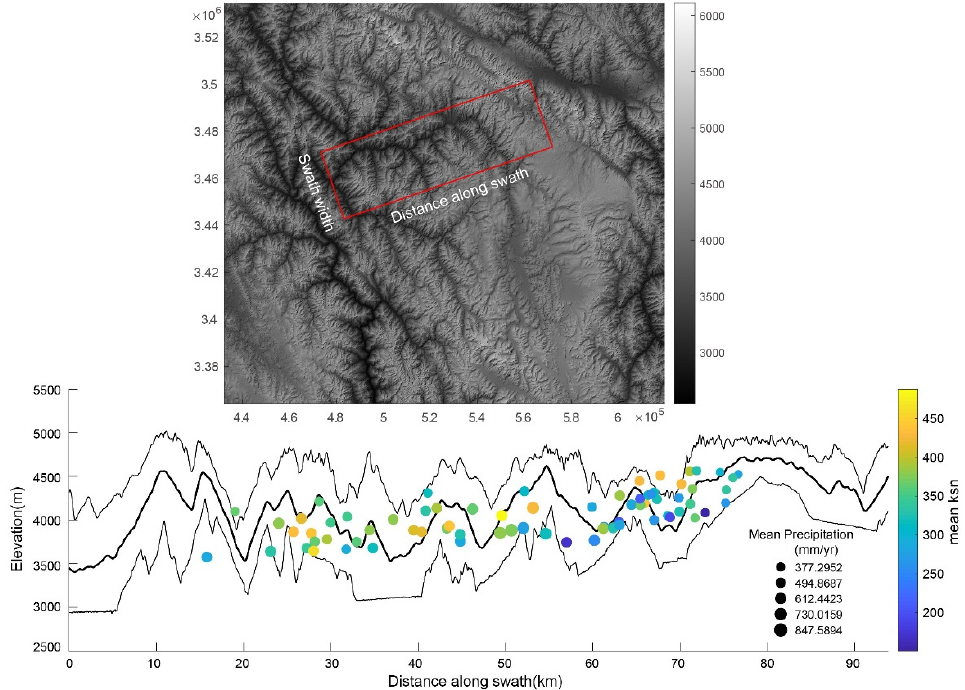
Figure 3. Swath profiles across the Zengqu River. Upper plot: location of swath topographic profiles. Lower plot: the black lines are maximum, mean, and minimum elevations along a 10-km wide swath from top to bottom, respectively. Mean annual averaged precipitation within basins (derived from TRMM data) in mm yr − 1 colored by mean channel steepness.